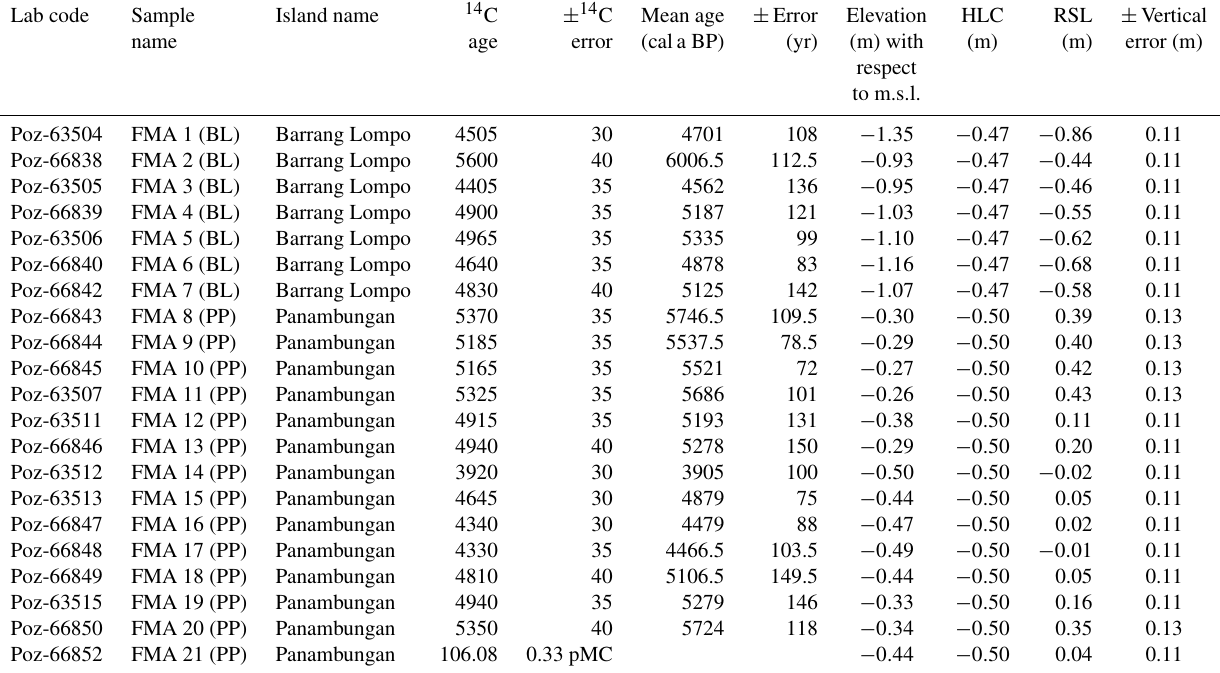
Figure 5. Results of the 54 GIA model runs for an island located in the center of the Spermonde Archipelago: (a) last 9kyr – dots indicate the points at which the maps in Fig. 6 have been extracted; (b) last 16kyr, representing the full time extent of the models. The eustatic sea level for each ice melting scenario is available in Rovere et al. (2020). The Jupyter notebook used to create this graph is available in Rovere et al. (2020). Table 3. Fossil microatolls sampled by Mann et al. (2016) surveyed on Barrang Lompo (FMA 1 (BL)–FMA 7 (BL)) and Panambungan (FMA 8 (PPB)–FMA 21 (PPB)). All ages are recalculated with a δR value of 0 and an error of 0 (Southon et al., 2002). All erosion corrections are already included in the RSL as provided in Mann et al. (2016), but all details are provided in the PANGAEA dataset associated with this paper. The elevation–age plot of these data is shown in Fig.